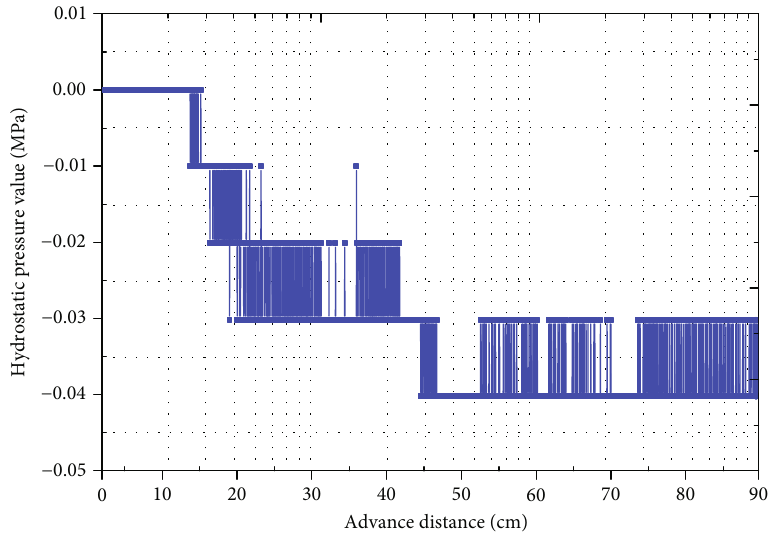
Figure 18: Pore water pressure at monitoring point P1-4 vs. the distance advanced.